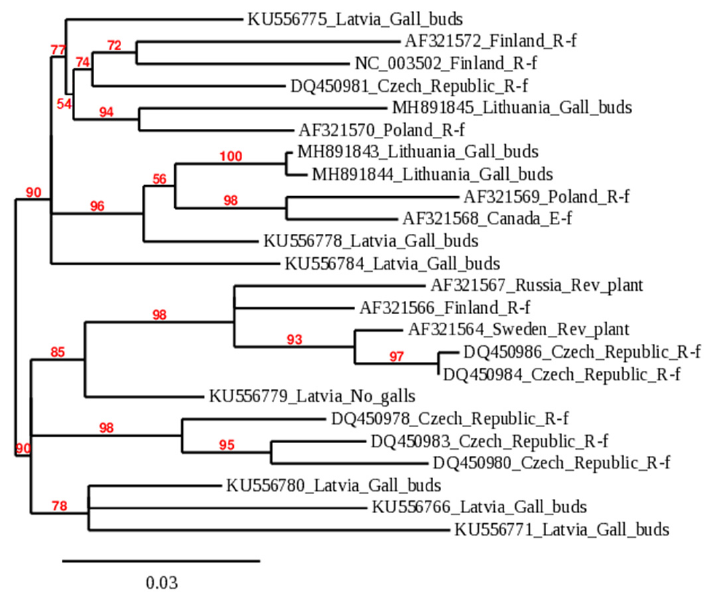
Figure 1. Genetic relationship among worldwide isolates of BRV according to 3 ′ NTR RNA2 se ‐ quences. The label of members in the phylogenetic tree consists of accession number in NCBI_coun ‐ try of origin_blackcurrant reversion disease form or symptom. Accession numbers of BRV sequences obtained in this research are MH891843–MH891845; characteristics of isolates of other plants shown in Figure 1 are available in Table S2 in Supplementary Materials.